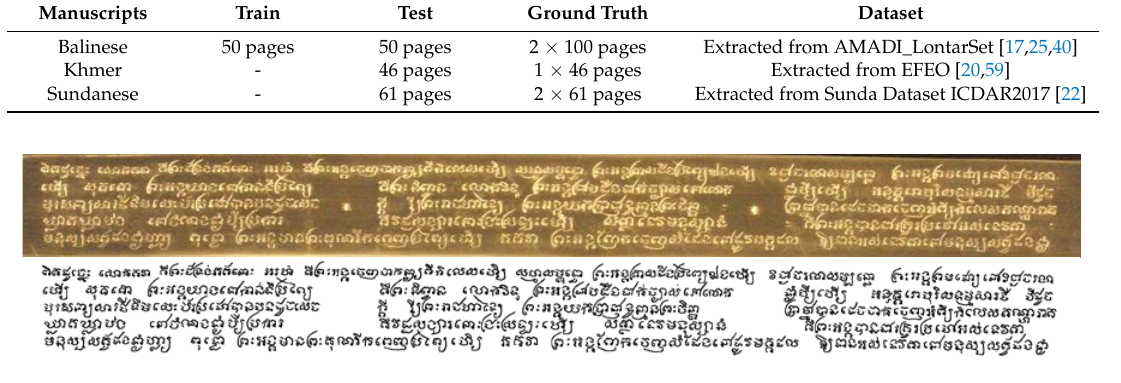
Figure 12. Balinese manuscript with binarized ground truth image.